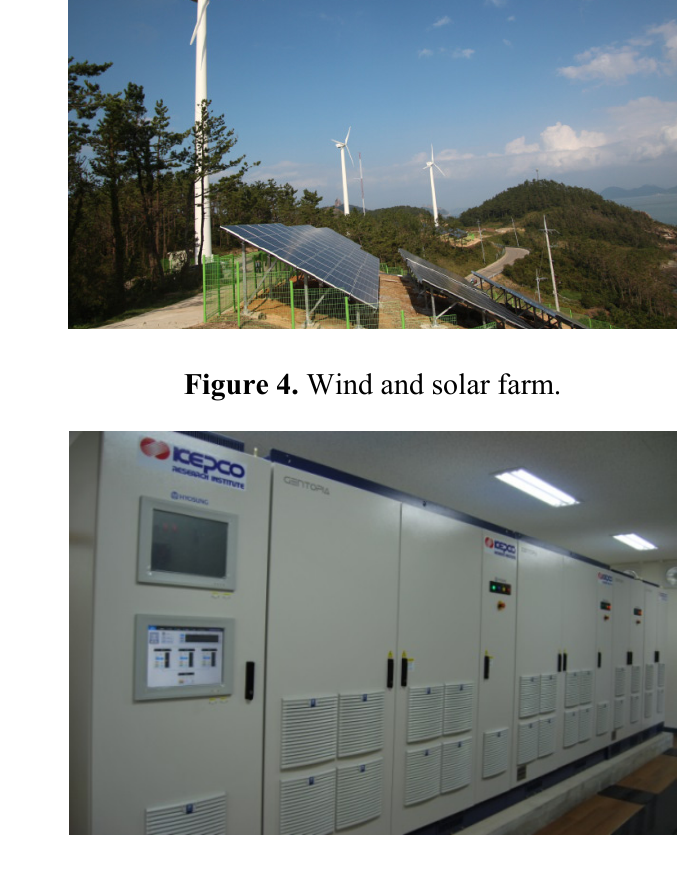
Figure 5. Grid forming inverters.